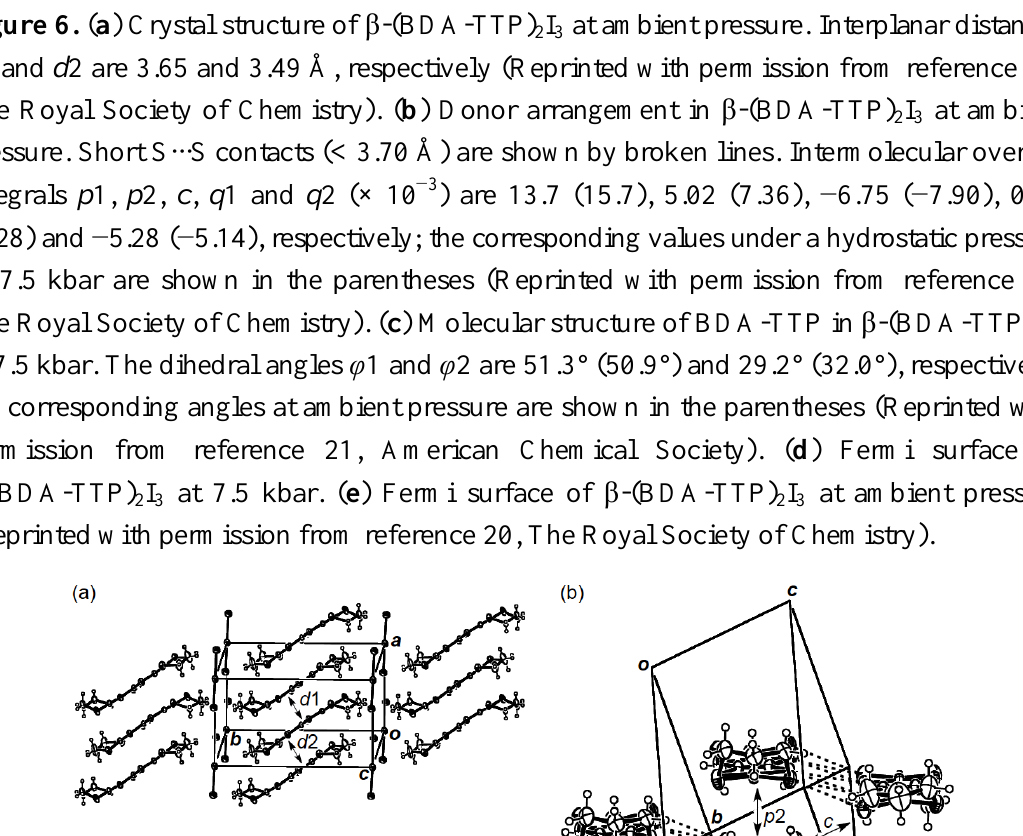
Figure 6. ( a ) Crystal structure of β-(BDA-TTP)